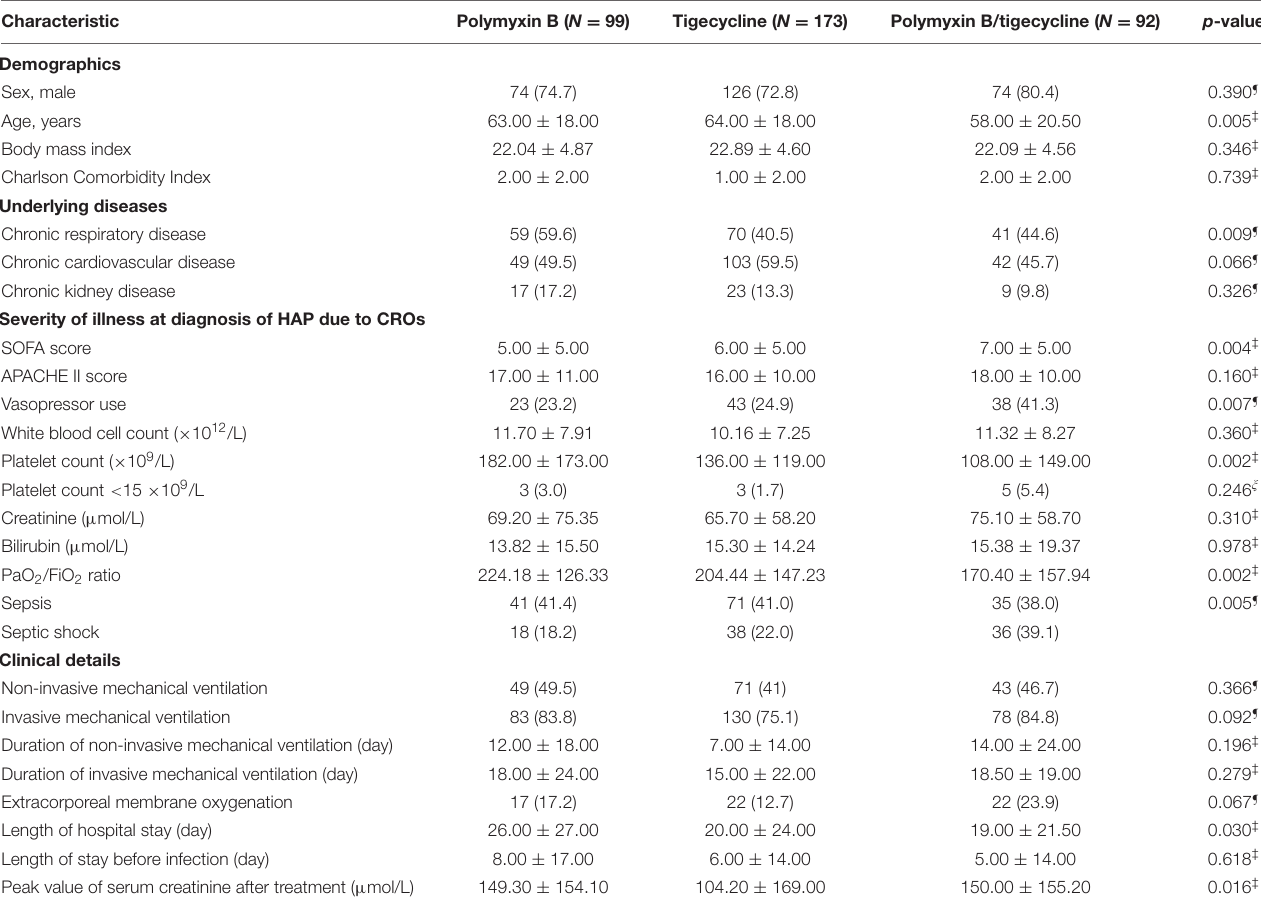
TABLE 1 | Baseline characteristics of patients in terms of polymyxin B and/or tigecycline treatment.